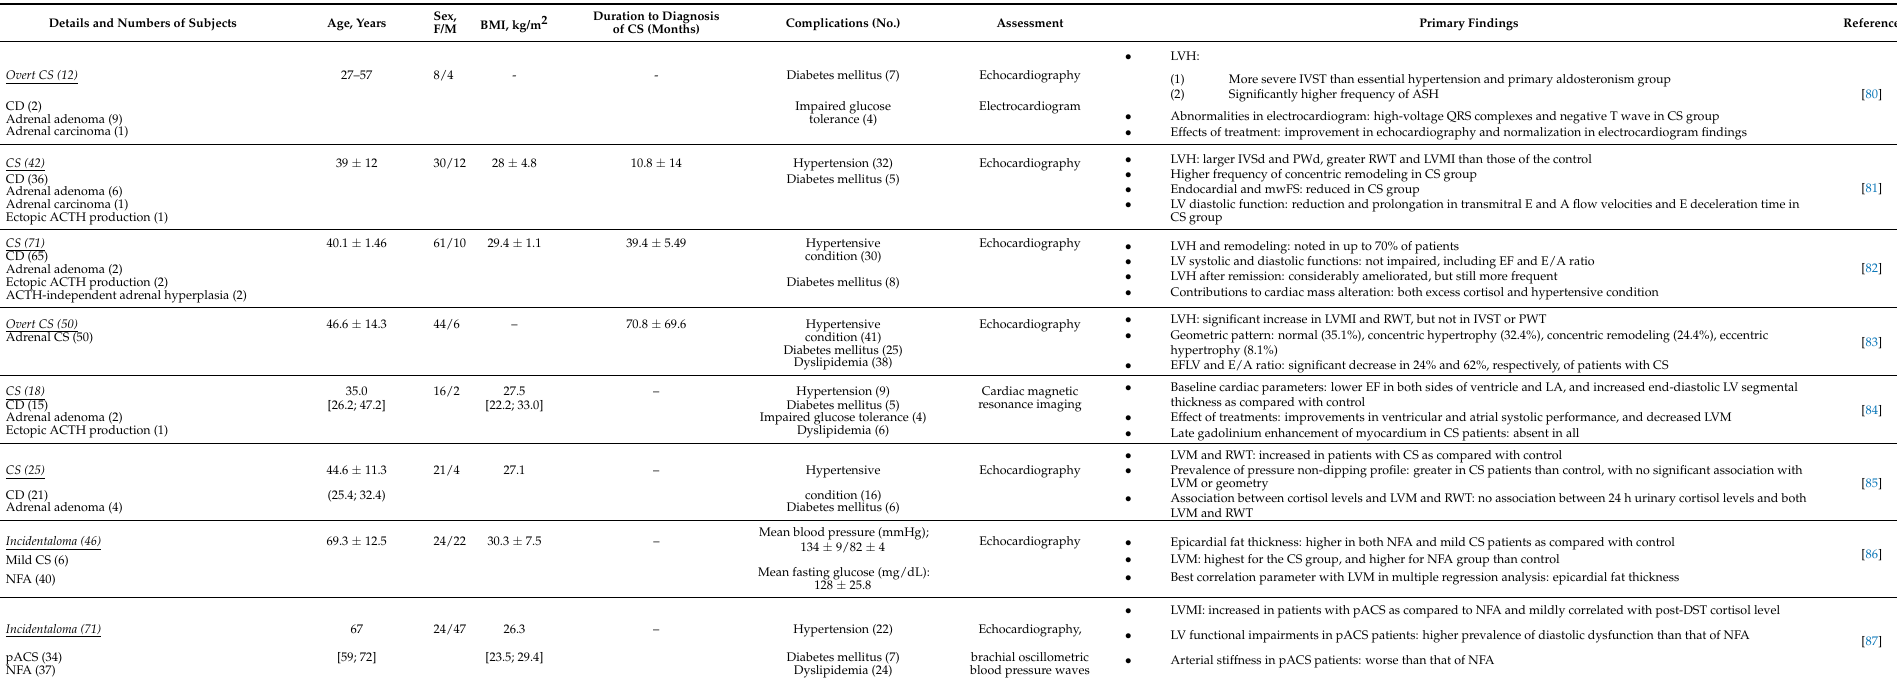
Table 1. Effects of hypercortisolemia on heart structure and function in Cushing syndrome